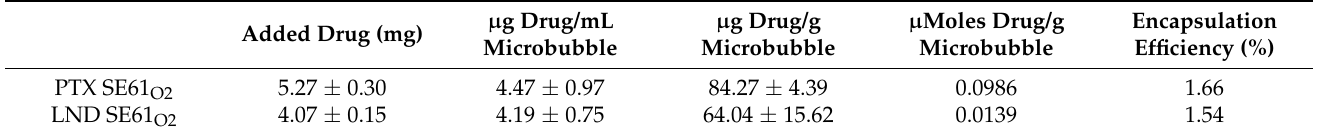
Table 2. Quantification of single-drug